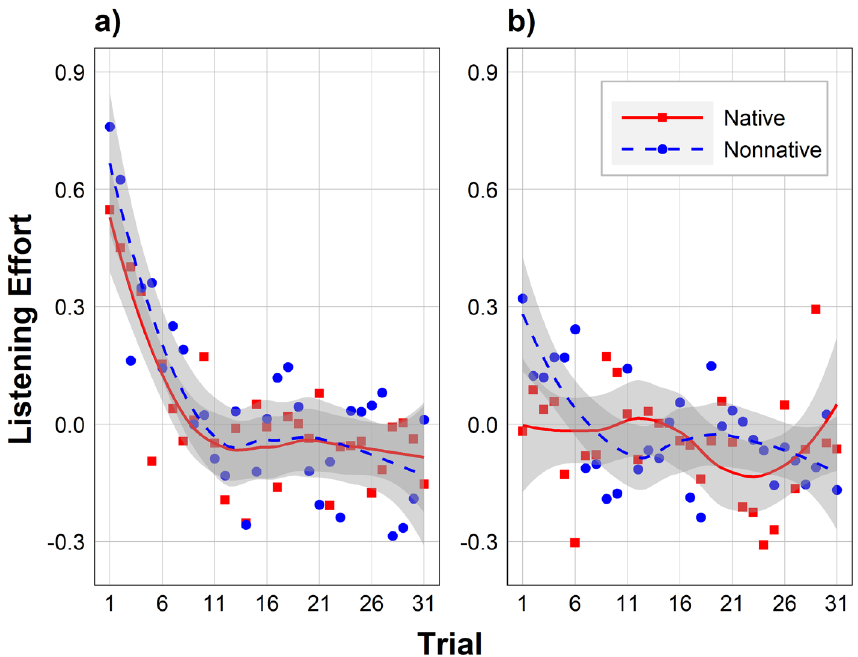
Figure 2. Effects of Accent and Trial on listening effort. Listening effort, expressed in z-scores, is shown in Block 1 ( a ; left) and Block 2 ( b ; right). Data points represent the mean of a condition across participants, lines are smoothed local regression lines of best fit (loess curves), and gray shading represents the 95% CI. Participants with the native accent in Block 1 (red line) become those with the nonnative accent in Block 2 (blue line), and vice